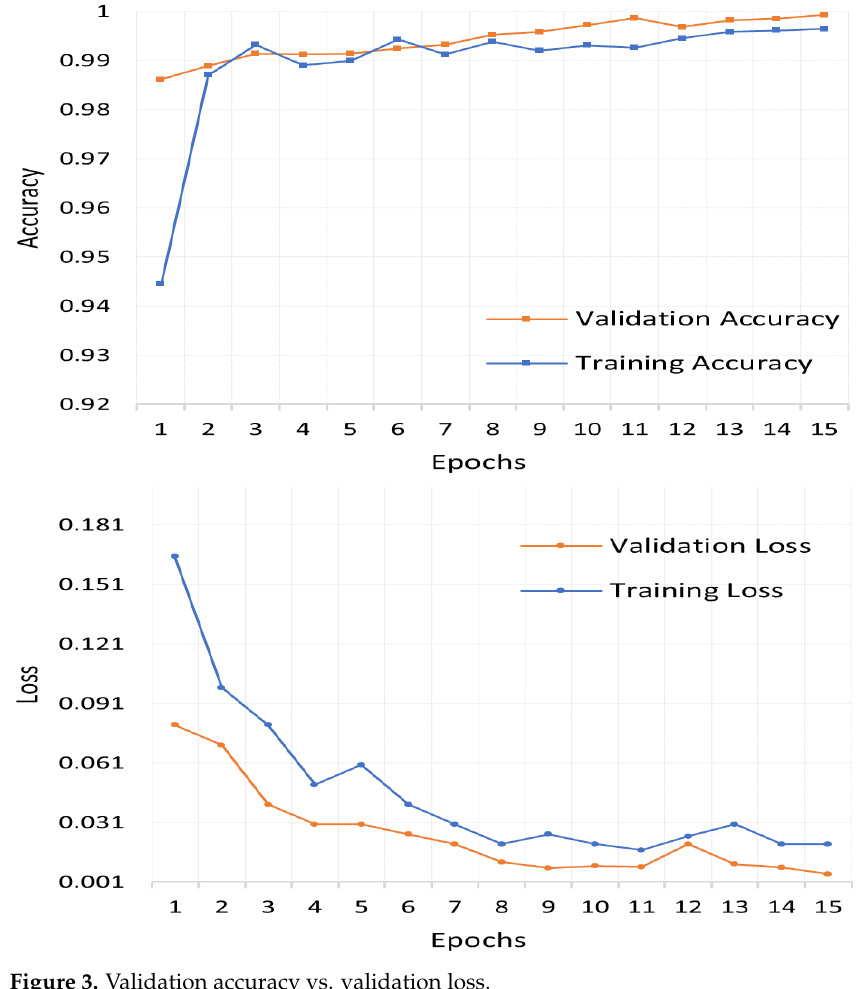
Figure 3. Validation accuracy vs. validation loss.